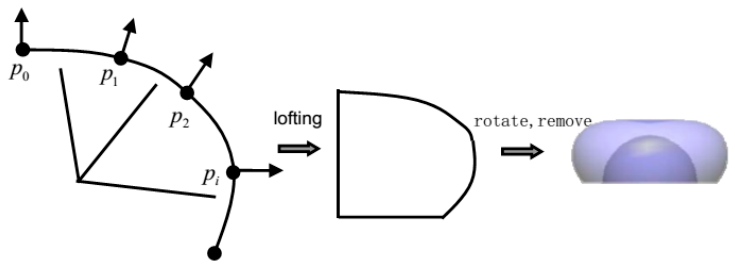
Figure 3. Schematic diagram of structuring free-curved lens.